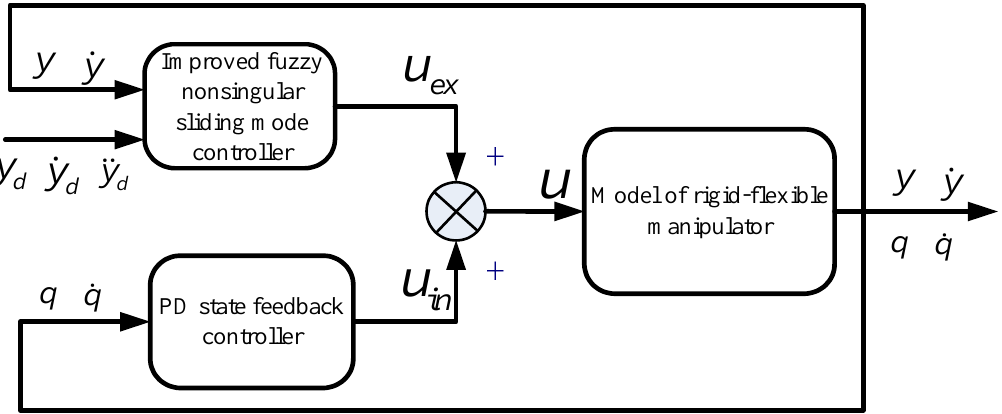
Figure 2. Diagram of the controller.